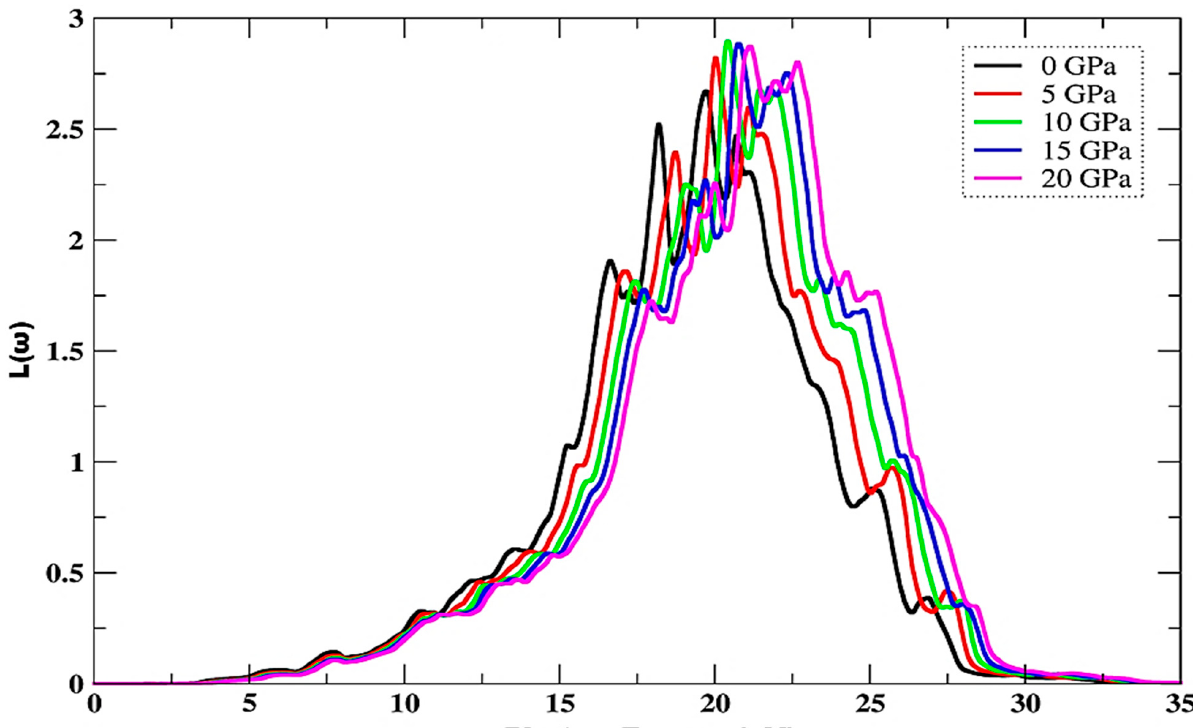
Figure 10. Pressure-influenced variations in energy loss function.